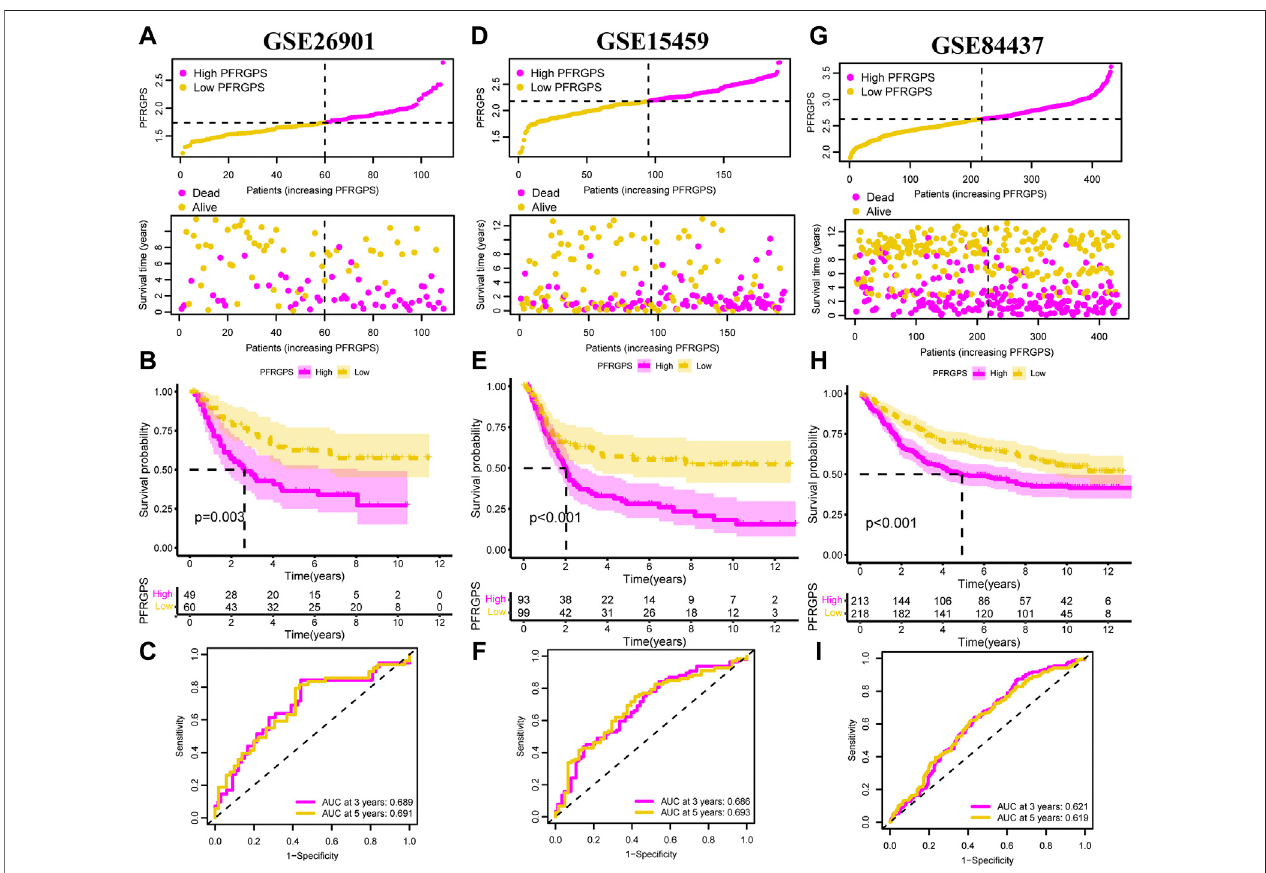
FIGURE4| PFRGPSwasvalidatedusingthreeindependentGEOdatasets.In (A – C) GSE26901, (D – F) GAE15459,and (G – I) GSE84437,distribution ofPFRGPS and survival status analysis, Kaplan-Meier survival analysis, ROC curve analysis were performed in the high- and low-PFRGPS subgroups. PFRGPS, platelet function- related genes prognostic score; ROC, receiver operating